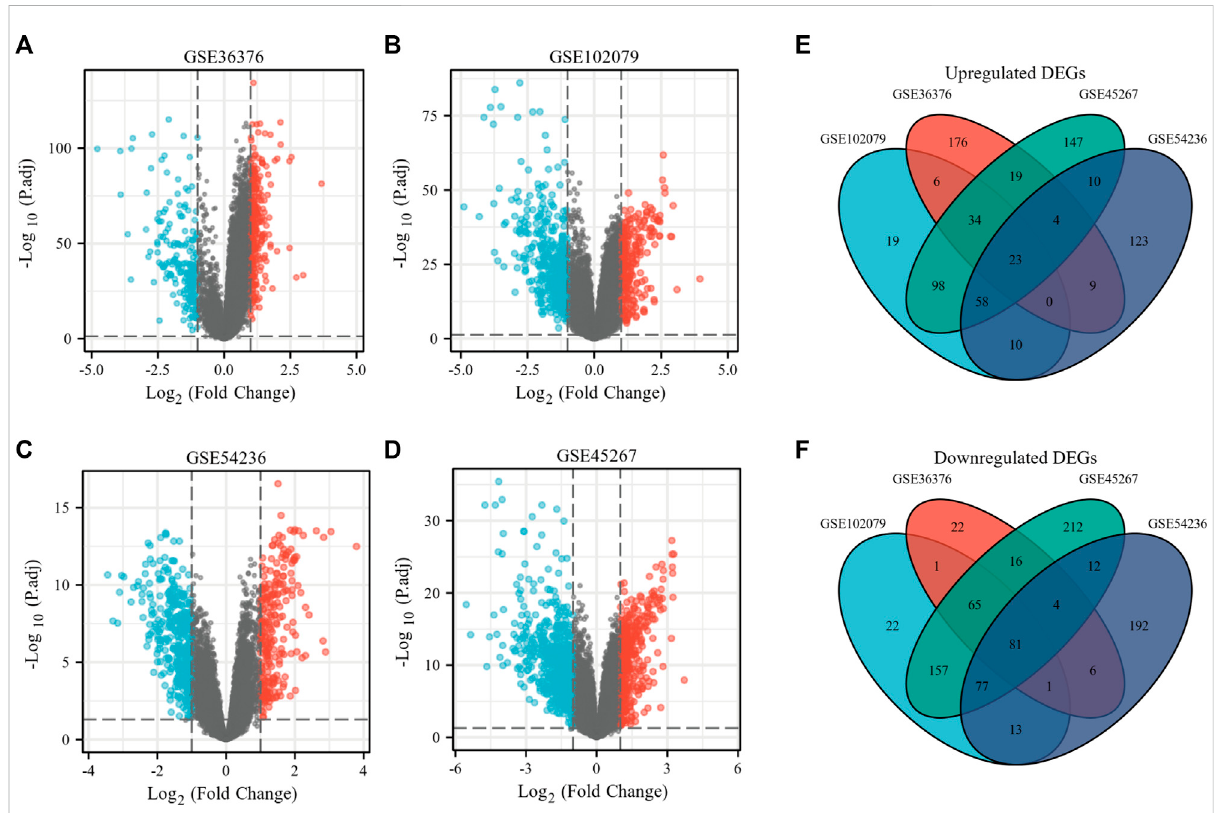
FIGURE 1 Identi fi cationofoverlappingDEGsinHCC. (A – D) Volcanoplotsofgeneexpressionpro fi ledatainGSE36376 (A) ,GSE102079 (B) ,GSE54236 (C) , and GSE45267 (D) , respectively. (E) Venn plots of up-regulated overlapping DEGs. (F) Venn plots of down-regulated overlapping